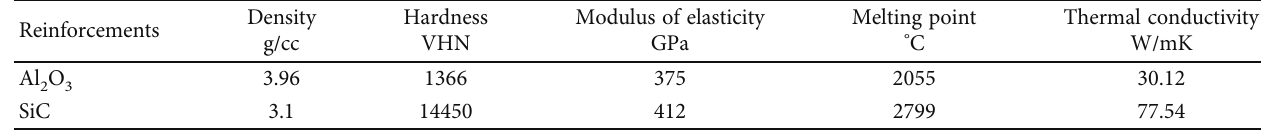
Table 2: Properties of reinforcements.